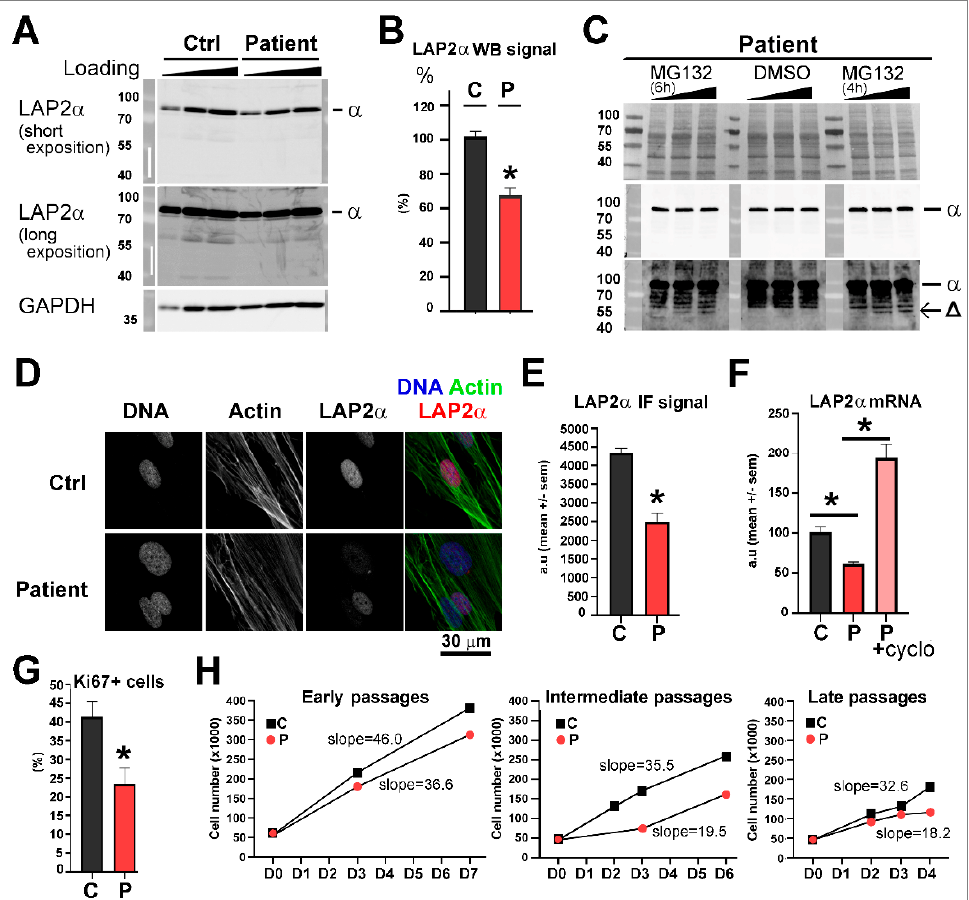
Figure 3. Expression of LAP2 α in dermal fibroblasts of a patient carrying the TMPO mutation p.(Gly395Glufs*11). ( A ) Whole-cell extracts of fibroblasts from one healthy male control (Ctrl) and patient 1 were analyzed by Western blot using anti-LAP2 α antibodies and anti-GAPDH antibodies to control loading of samples. ( B ) The graph shows ECL signal quantification (mean ± s.e.m.) of full-length LAP2 α proteins expressed in human dermal fibroblasts (n = 8 experiments, GAPDH or Actin used as reference proteins). * p < 0.05. ( C ) Whole-cell extracts of fibroblasts from patient 1 pretreated with or without 20 µ M MG132 for either 4h or 6h, as indicated, and analyzed by Western blot using anti-LAP2 α antibodies. Are shown two expositions for the ECL revelation (short exposition in the middle panel; longer exposition in the lower panel). Signs α and ∆ indicate the detection of full-length LAP2 α and truncated LAP2 α , respectively. Red ponceau is also shown in the upper panel. ( D ) Dermal fibroblasts were labeled with anti-LAP2 α antibodies (red) and phalloidin to reveal the actin network (green). DNA was stained with Hoechst (blue). Scale bar, 30 µ m as indicated. ( E ) Relative intensity of LAP2 α immunofluorescence (IF) signals per nucleus in fibroblasts from the control (C) and the patient (P) (n = 5 experiments, n = 120–170 nuclei for exps 1–3, n = 520–650 nuclei for exps 4-5). * p < 0.05 (Mann–Whitney test). ( F ) LAP2 α mRNA quantification